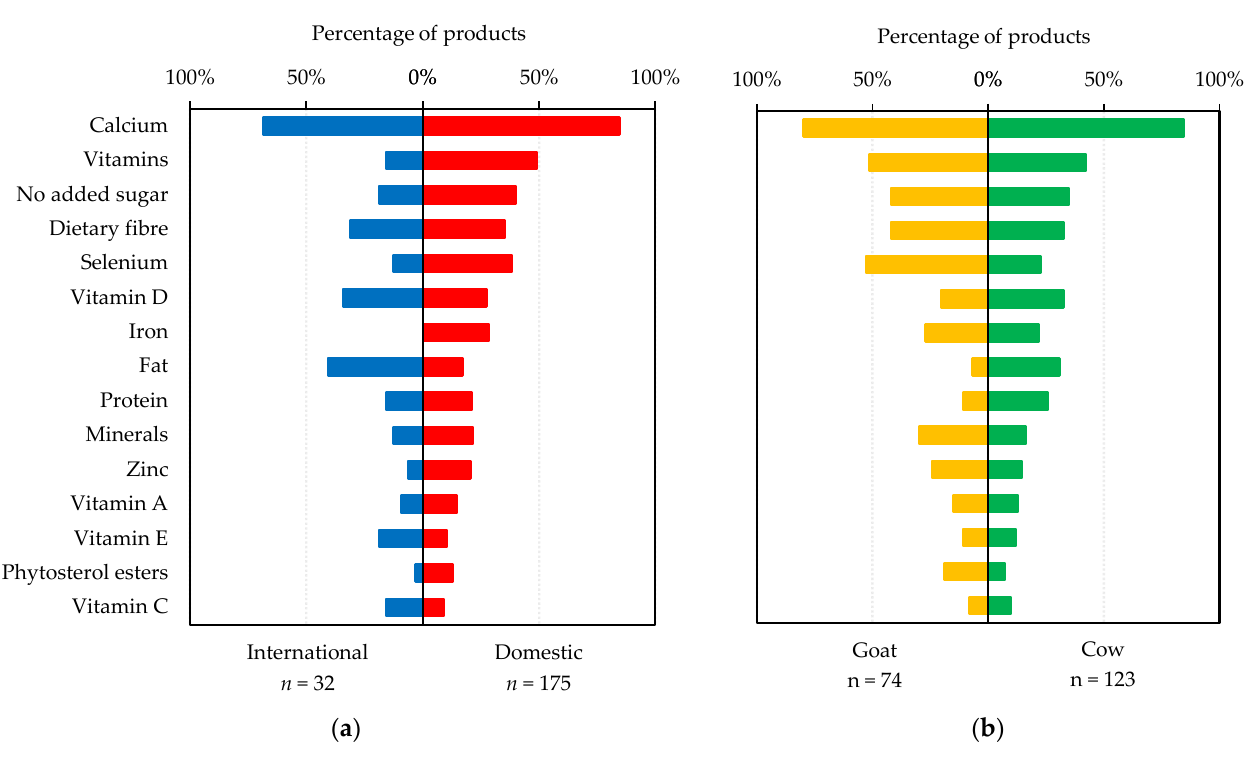
Figure 4. Percentage of milks targeting Chinese older adults made nutrition claims on specific nutrients that appeared on at least 5% of all products: ( a ) international brand vs. domestic brand; ( b ) goat milk vs. cow milk.